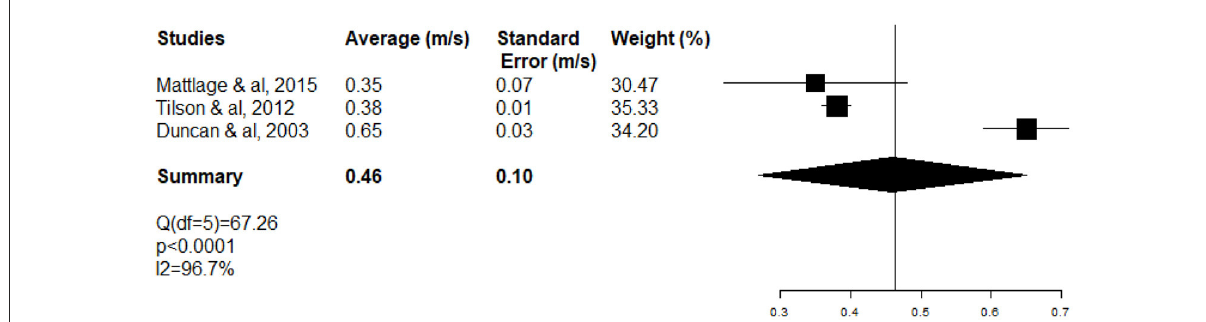
FIGURE4 Forest plot of long-distance WS at the acute and subacute stages of stroke (ASSS).